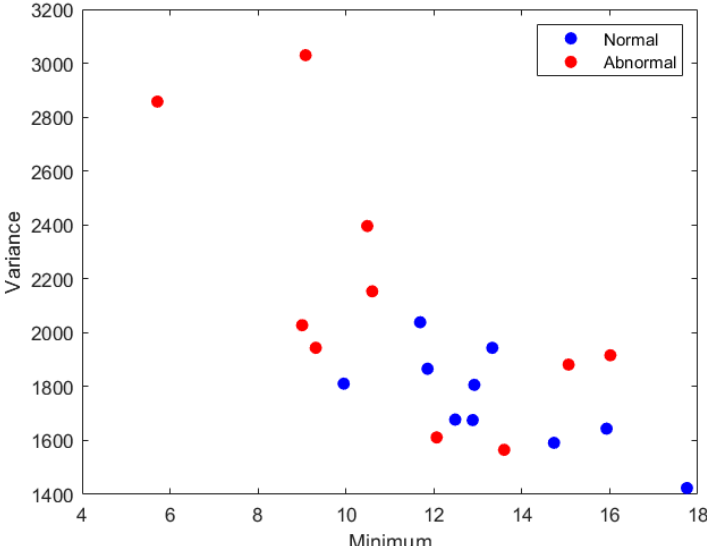
Figure 6. The variance feature values versus the minimum feature values for the second 10 samples of images and their rotated versions.